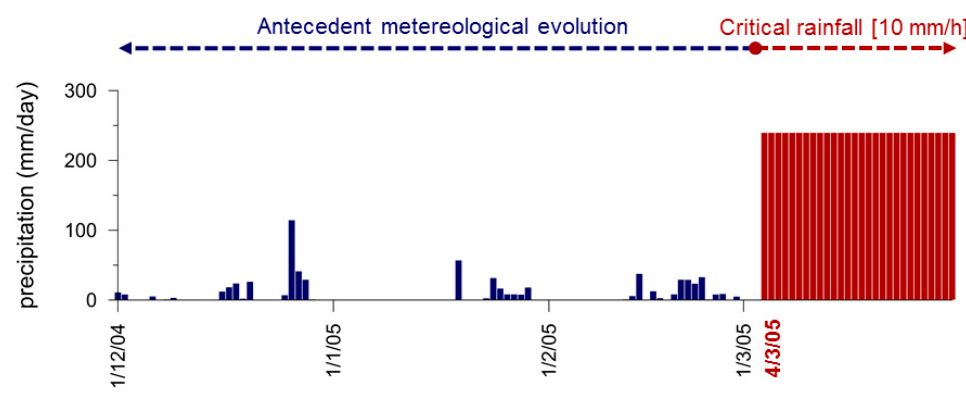
Figure 6. Final part of the rainfall history applied in analyses of set B, C, and D (1st December 2004–3rd March 2005).